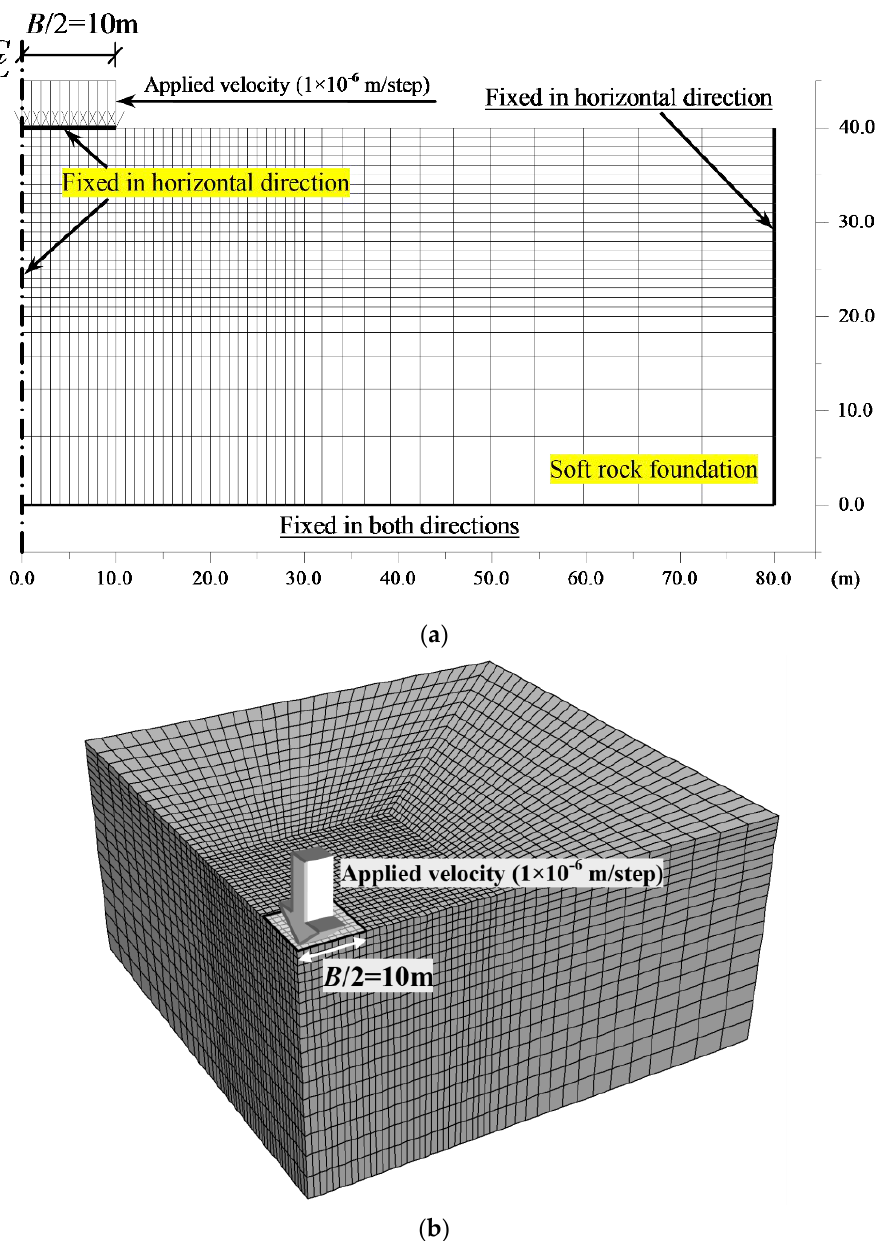
Figure 5. Finite difference meshes with boundary conditions used for analysis: ( a ) Strip or circular footing (symmetrical model), ( b ) Square footing (quarter model).